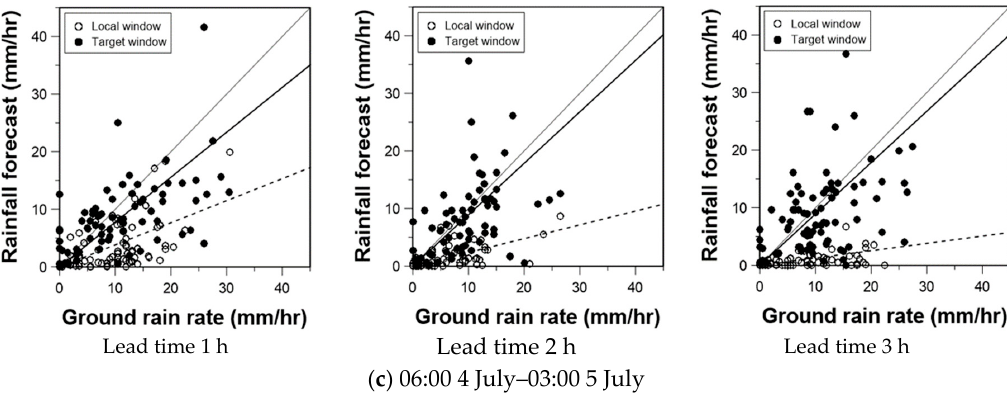
Figure 7. Comparison results of ground data and rainfall forecast at the local and target windows for the rainfall event on 4 July ( a ) at the beginning of rainfall, ( b ) after three hours, and ( c ) all the available cases.